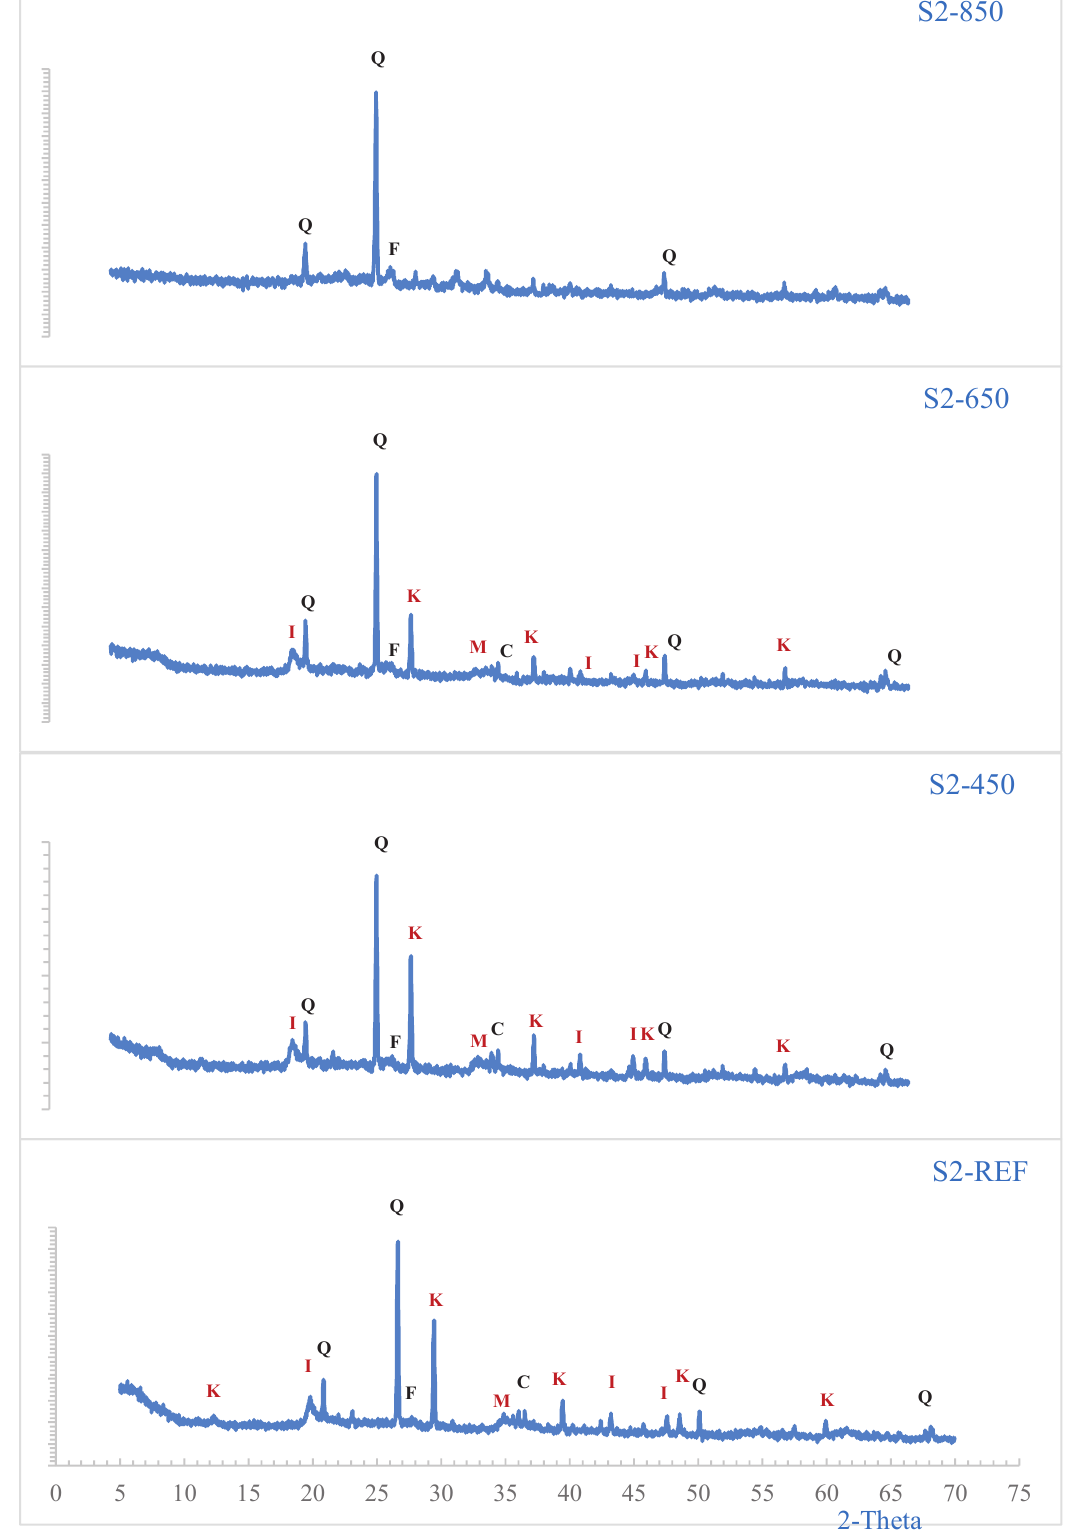
Figure 4. XRD analysis of the soil S2 before and after the thermal treatment (I: illite; Q: quartz; M: montmorillonite; K: kaolin; F: feldspar; C: calcite).